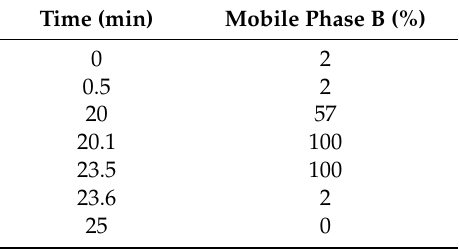
Table 3. Free amino acids gradient elution